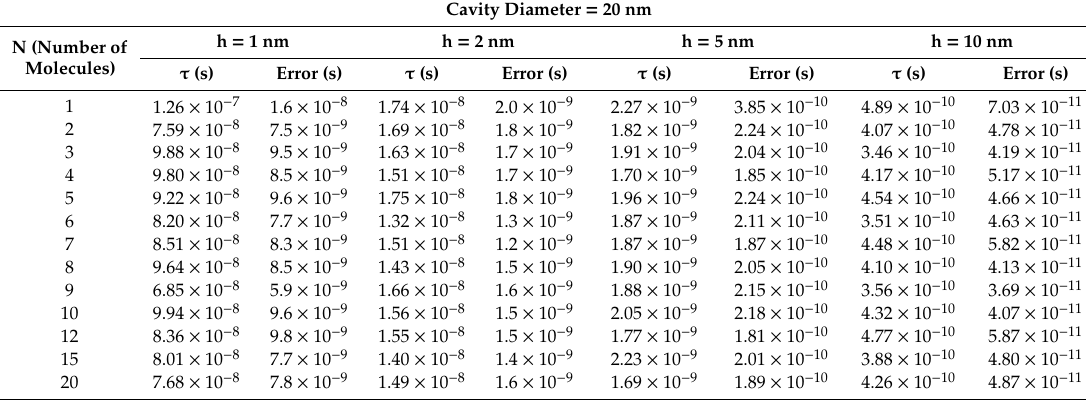
Table A6. Mean escape time ( τ ) and associated errors of di ff erent number molecules confined in a 20-nm spherical cavity for di ff erent entrance–escape hole diameters (h) calculated by the interactive random walk models for 10 2